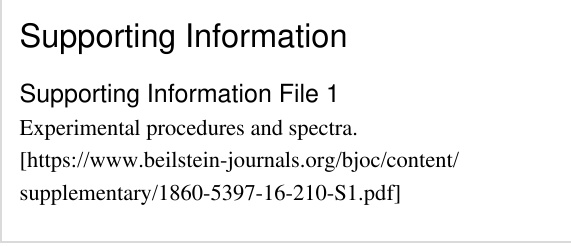
switching efficiency at unphysiological pH 10.5 [14].